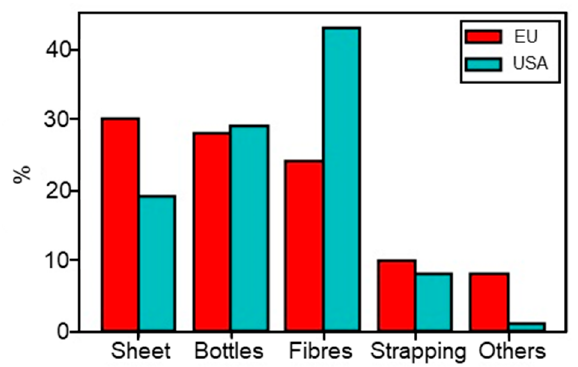
Figure 14. Applications of rPET in the EU and USA [246,254].